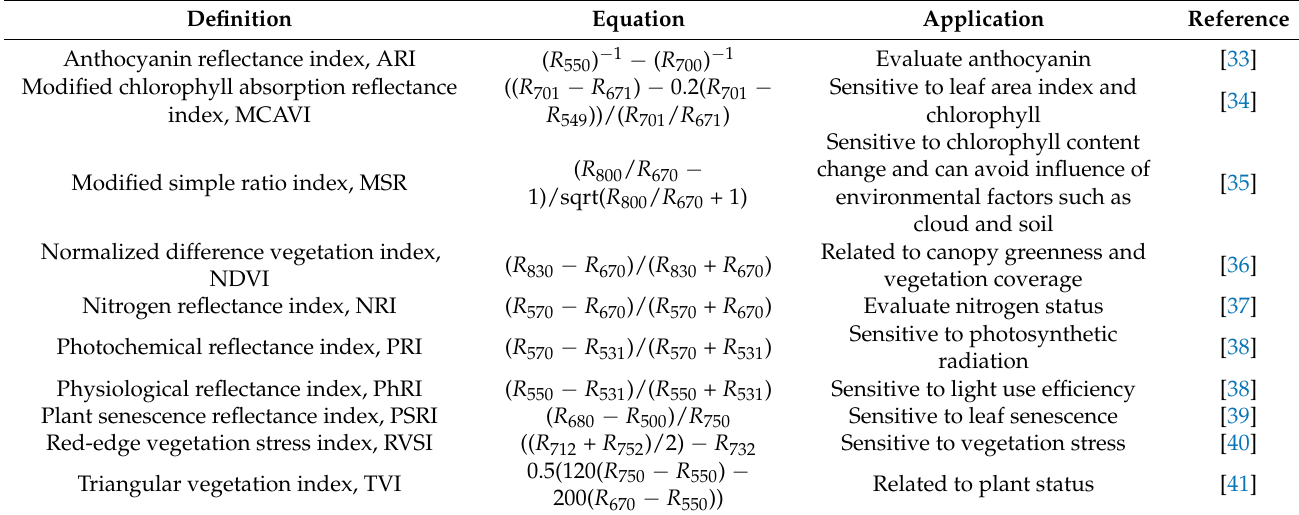
Table 1. VIs used for detecting wheat FHB in this